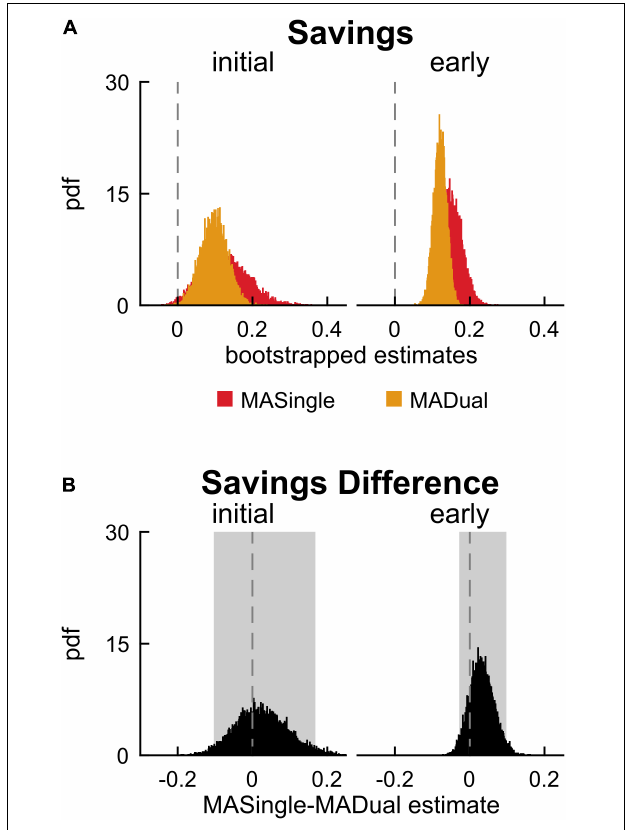
FIGURE 8 | Savings in single- and dual-tasking late middle-aged adults. (A) PDF of savings (difference in step length asymmetry between readapt and adapt) during the initial (strides 1–5) and early (strides 6–30) time epochs, for single-tasking (MASingle, red) and dual-tasking (MADual, orange) late middle-aged adults. (B) PDF (and shaded 95% CI) of the difference of the means between MASingle and MADual for savings measures. PDFs and CIs are obtained through bootstrapping. Savings does not differ between MASingle and MADual